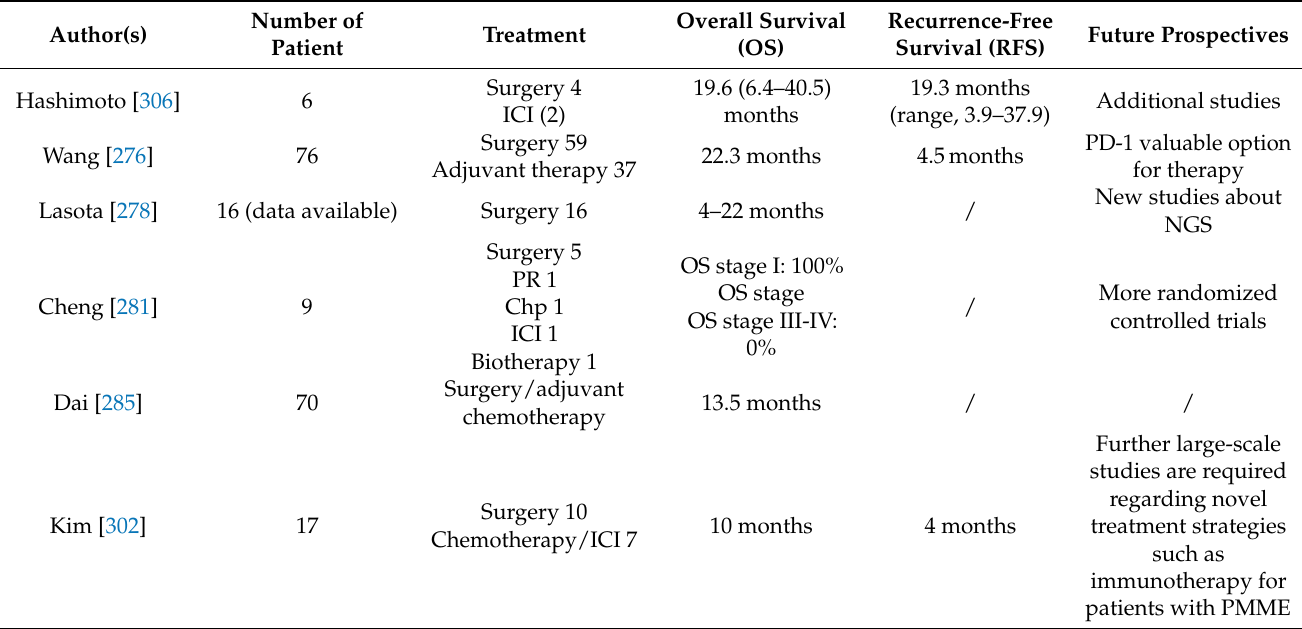
Table 1. Overall Survival and Regression-free Survival data from some studies with a great number of patients with